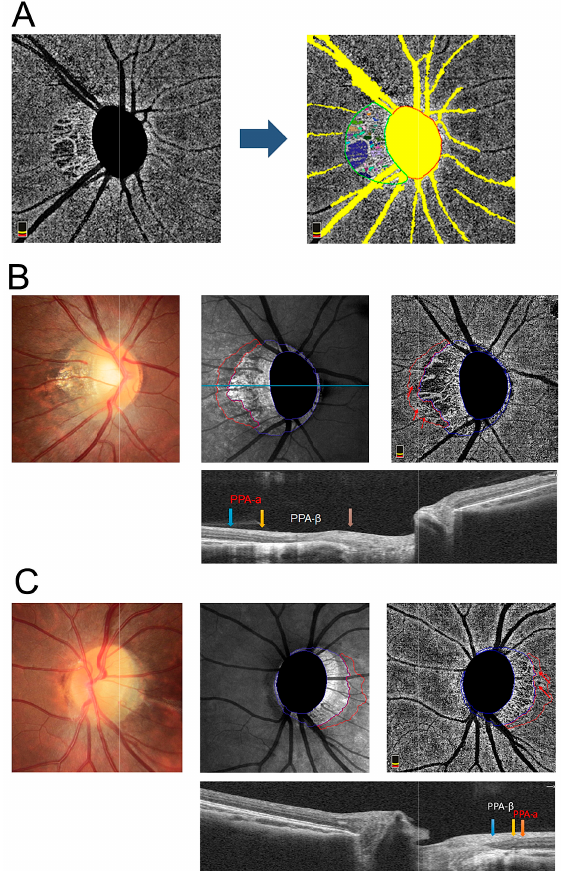
Figure 1. Case of high myopia with peripapillary microvascular dropout (MvD) in both peripapillary atrophy (PPA)- β and PPA- α zone. ( A ) Scanning laser ophthalmoscope image (SLO) of OCTA was proceeded with auto-segment of MvD (color areas in green-circled region) after removinglarge vessels and. ( B , C ) Peripapillary multimodal images of a 23-year-old female with − 6.00 diopters (D) and a 21-year-old female with − 6.50 D. The PPA- α zone is circled blue on SLO image and correspondingly lies between blue arrow and yellow arrow on OCT image. The PPA- β zone is circled red on SLO image and correspondingly lies between the yellow arrow and orange arrow on the OCT image. Red arrow indicates the MvD within the PPA- α